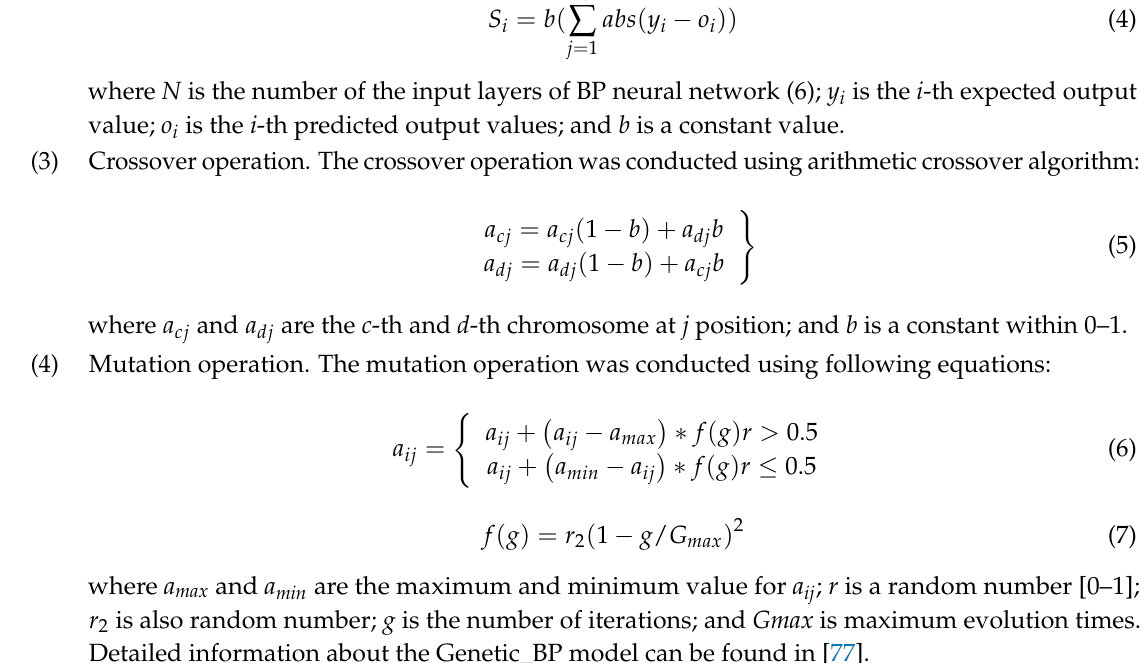
Figure 4. The basic schematic architecture of the BP neural network used in this study.